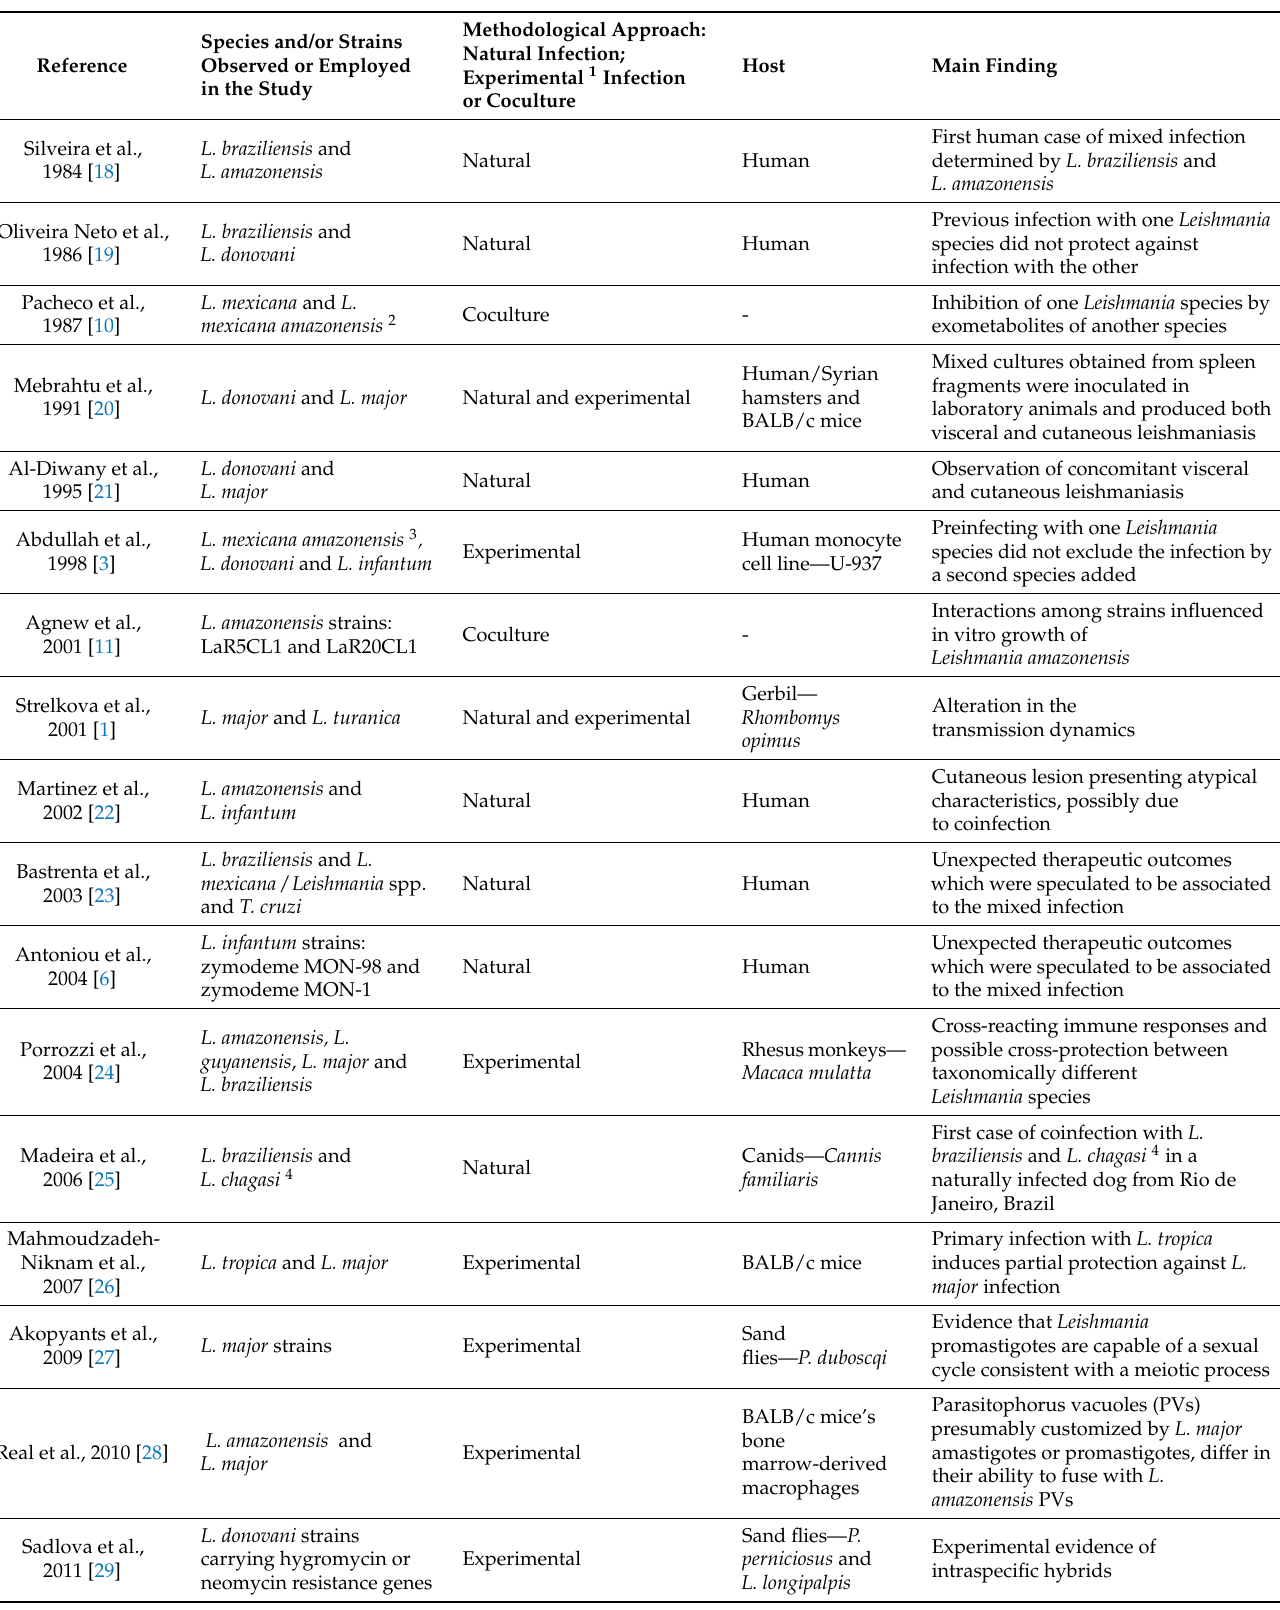
Table 1. Summary of studies reporting natural or experimental interactions among Leishmania species or